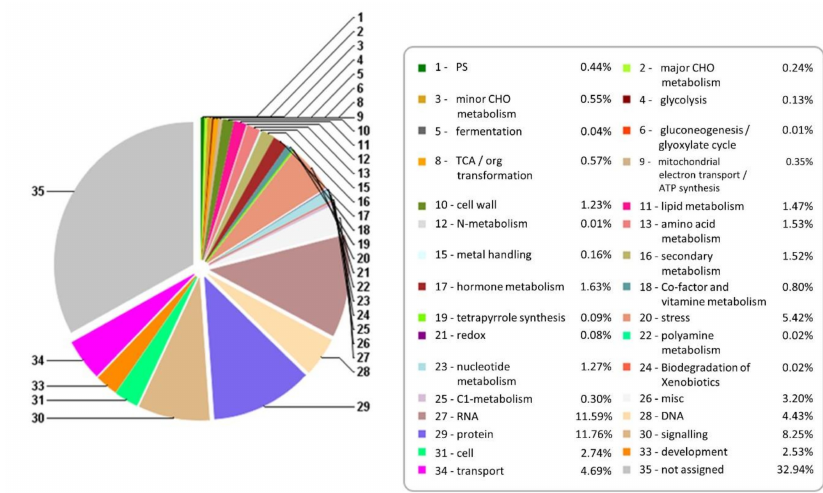
Figure 3. Mercator annotation of combined DEGs (di ff erentially expressed genes in TAS and SAS).